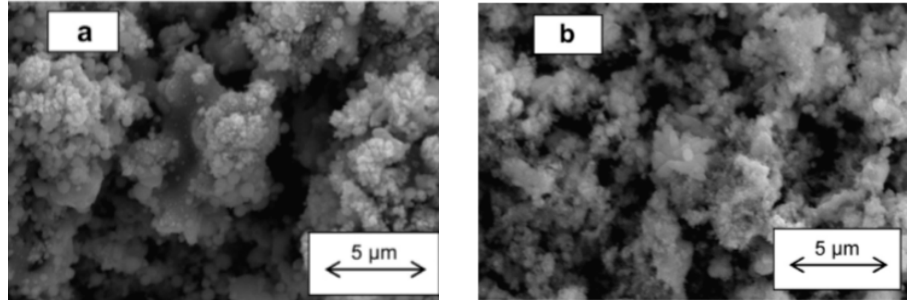
Figure 14. Scanning electron micrographs of ( a ) Ni-YSZ and ( b ) Ni-SDC SPPS cermet coatings. Reproduced with permission from [26], Elsevier, 2012.